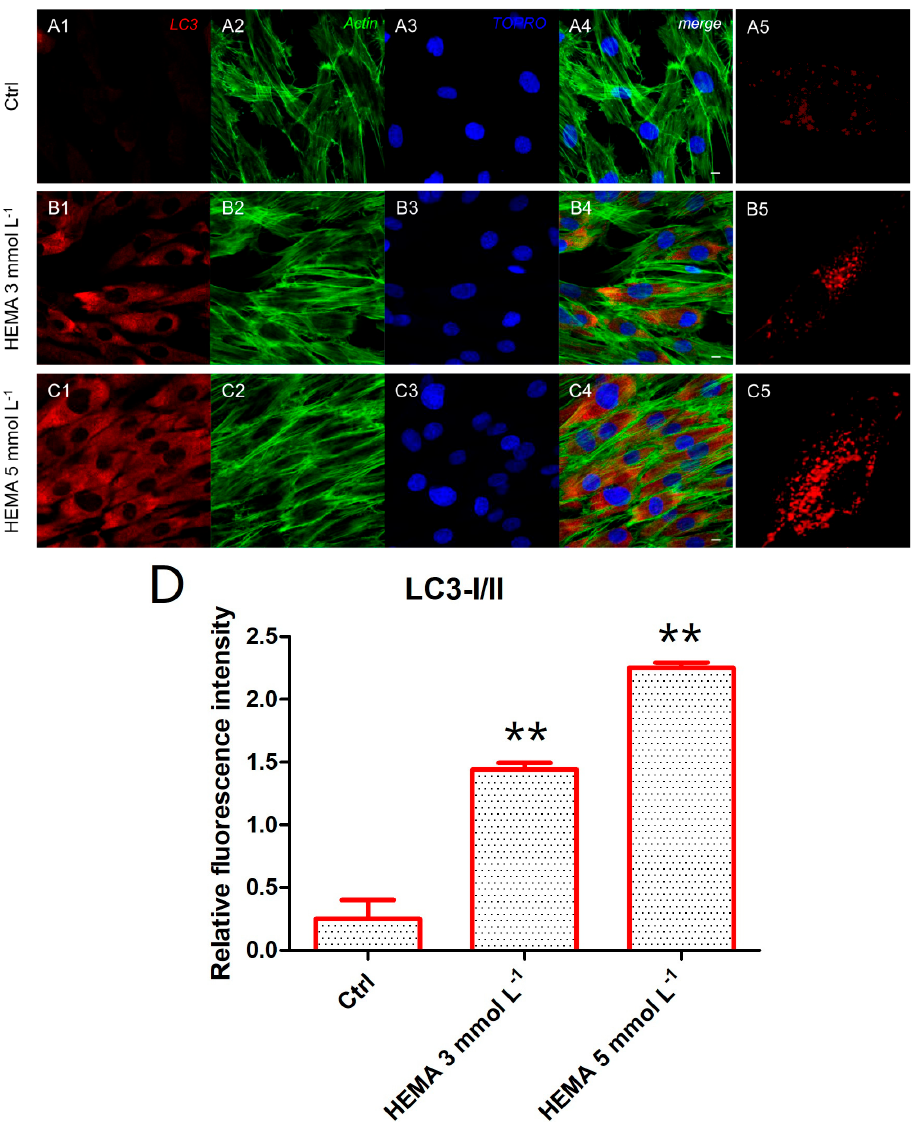
Figure 7. LC3 expression. ( A1 ) Untreated cells showed a negative expression for LC3 marker. ( A2 ) Actin cytoskeleton in untreated hDPSCs. ( A3 ) Nuclei in untreated hDPSCs. ( A4 ) Merged picture